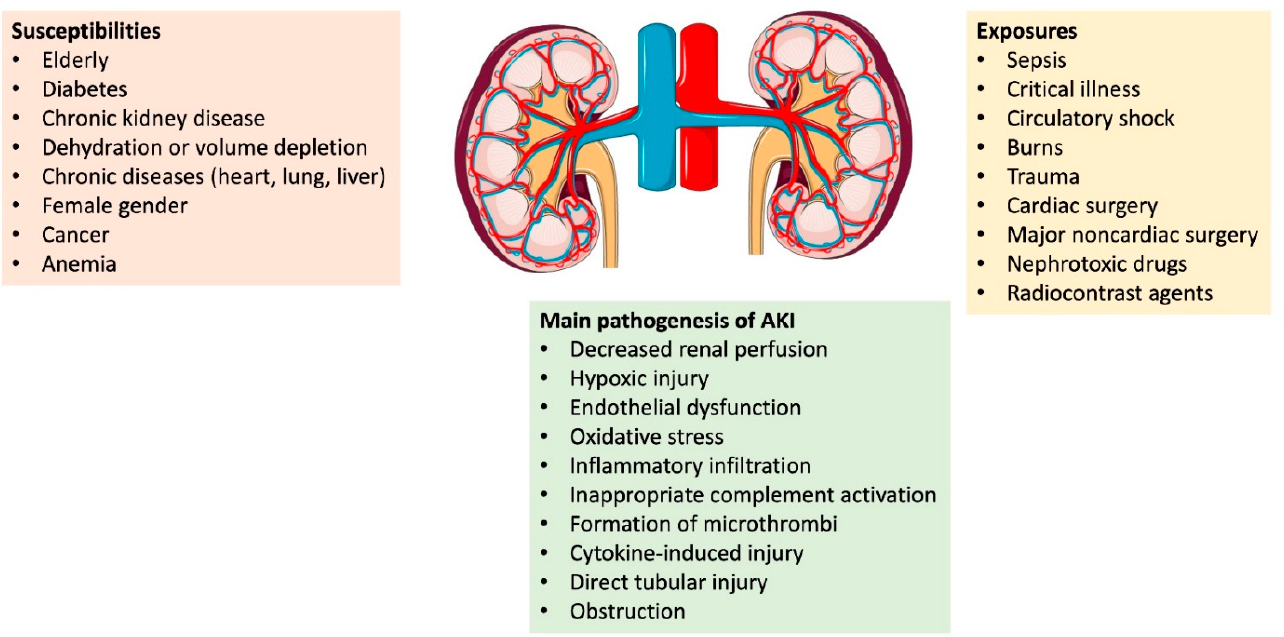
Figure 1. Risks and Pathogenesis of AKI